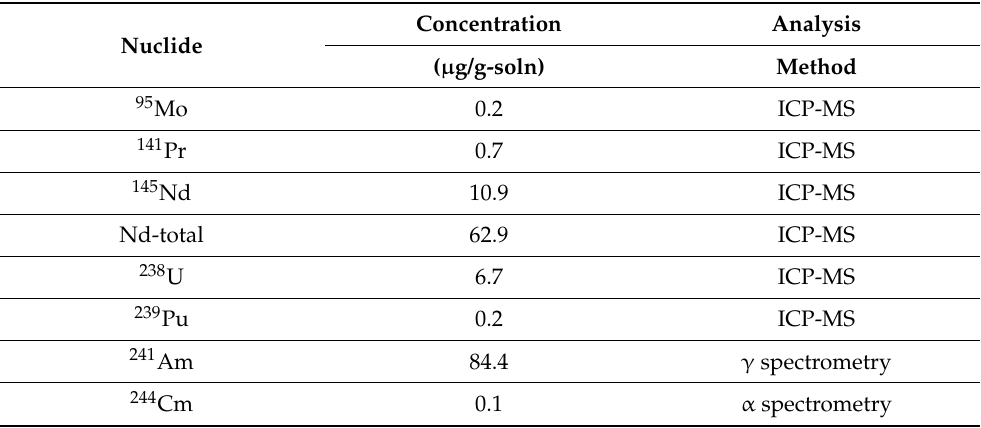
Table 1. Analytic results of the genuine MA effluent used for the separation experiment. Concentration Analysis Nuclide ( µ g/g-soln) Method 95 Mo 0.2 ICP-MS 141 Pr 0.7 ICP-MS 145 Nd 10.9 ICP-MS Nd-total 62.9 ICP-MS 238 U 6.7 ICP-MS 239 Pu 0.2 ICP-MS 241 Am 84.4 γ spectrometry 244 Cm 0.1 α